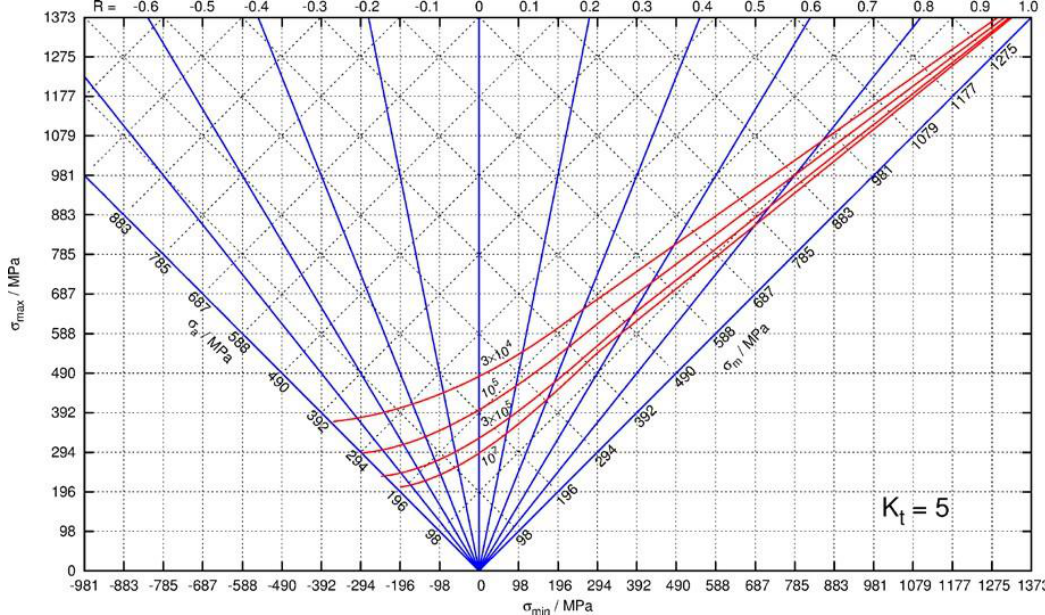
Figure 10. Constant life curve of K t = 5 based on median fatigue life.